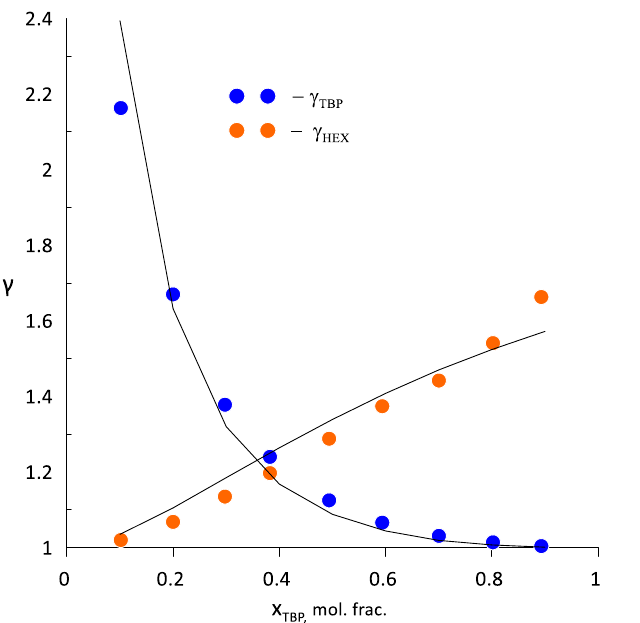
Figure 2. Comparison of the experimental (geometric figures) and calculated data (lines) of the activity coefficients for the TBP–hexane mixture [50].